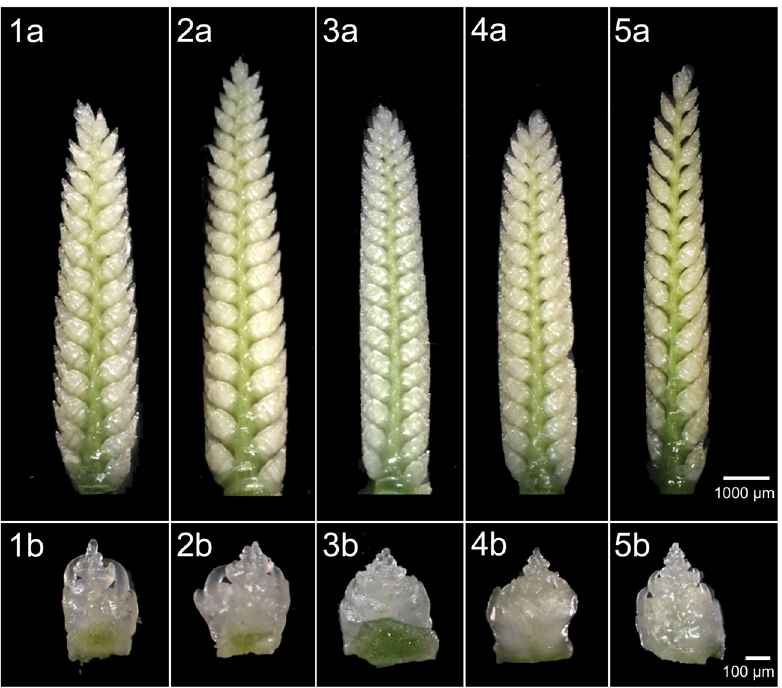
Fig. 4 Morphology of spikes and spikelet at terminal spikelet (TS) stage. The spike morphology at TS in line ( 1a ) CS, ( 2a ) N1D/T1A, ( 3a ) Dt1DS, ( 4a ) 1DL-6, ( 5a ) CSDt1DSAL and at the basal spikelets in line ( 1b ) CS, ( 2b ) N1D/T1A, ( 3b ) Dt1DS, ( 4b ) 1DL-6, ( 5b )